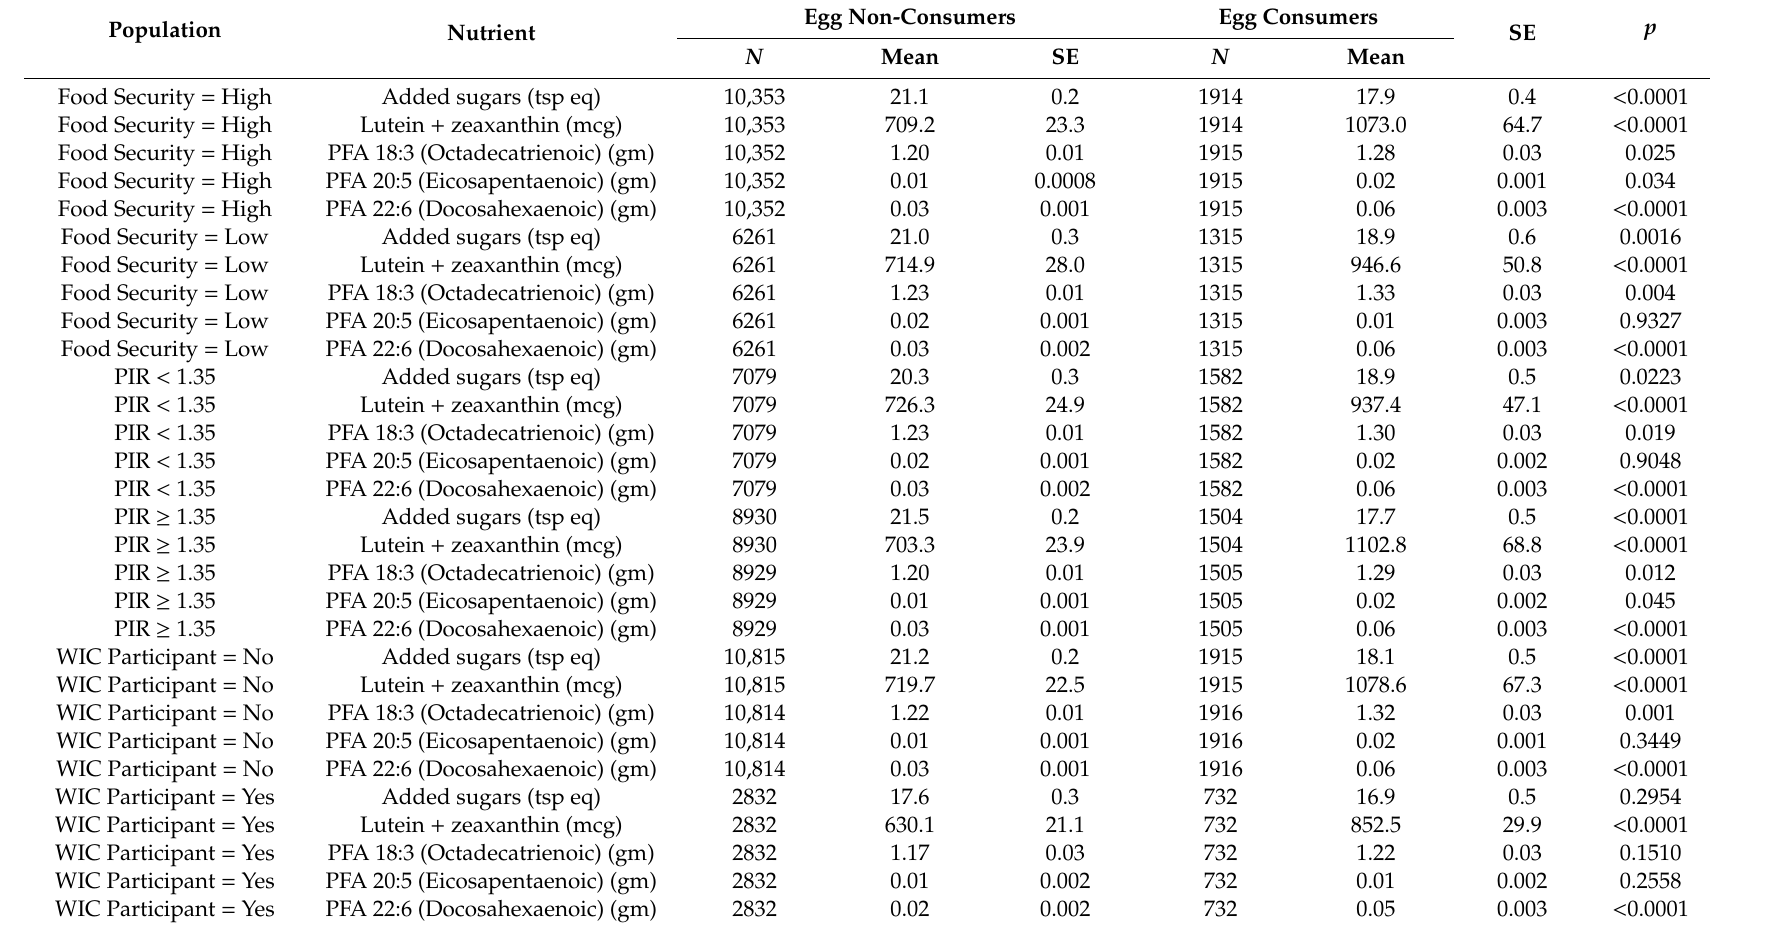
Table 4. Day 1 daily Intakes of added sugar, lutein / zeaxanthin, and omega-3 fatty acids by food security, poverty income ratio (PIR) and Special Supplemental Nutrition Program for Women, Infants, and Children (WIC)